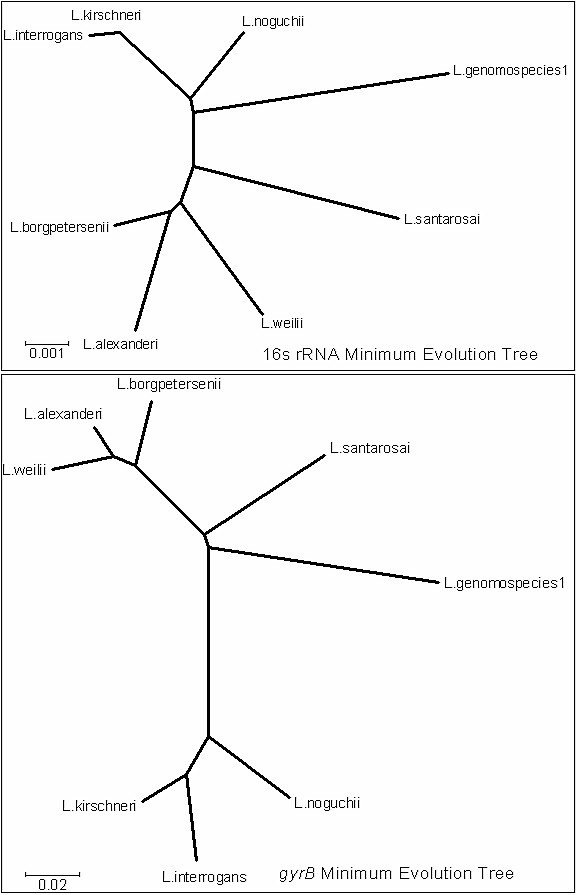
Minimum evolution trees of the gyrB and 16s rRNA gene created using the MEGA V3.1 Software package.